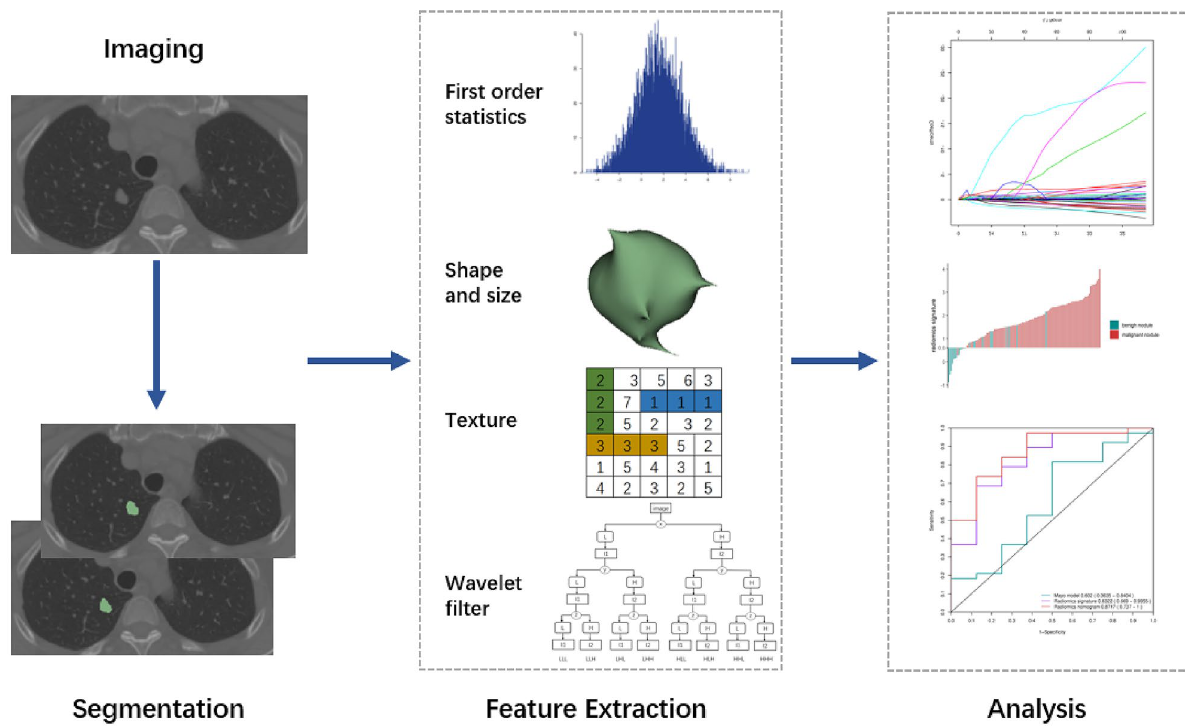
Figure 1. Radiomics study flowchart. Radiomics flowchart. ( A ) Nodules were manually segmented on plain CT images. ( B ) Three categories of radiomics features were extracted from original CT, and wavelet features were extracted after wavelet decomposition. ( C ) After features selection, the most informative radiomics features and clinical features were combined to construct machine learning model. Model performance was assessed using ROC, calibration curve, DCA and et.al.